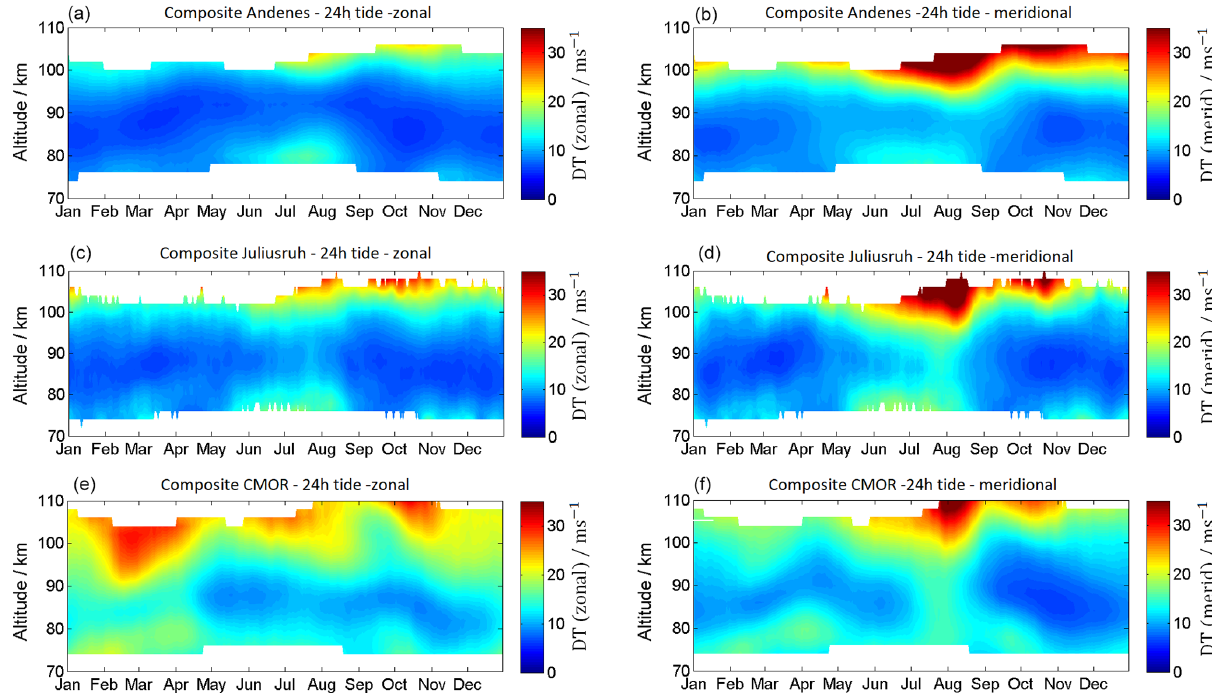
Figure 8. Composites of the zonal (a, c, e) and meridional (b, d, f) diurnal tidal components for Andenes (a, b) , Juliusruh (c, d) , and CMOR (e, f) .